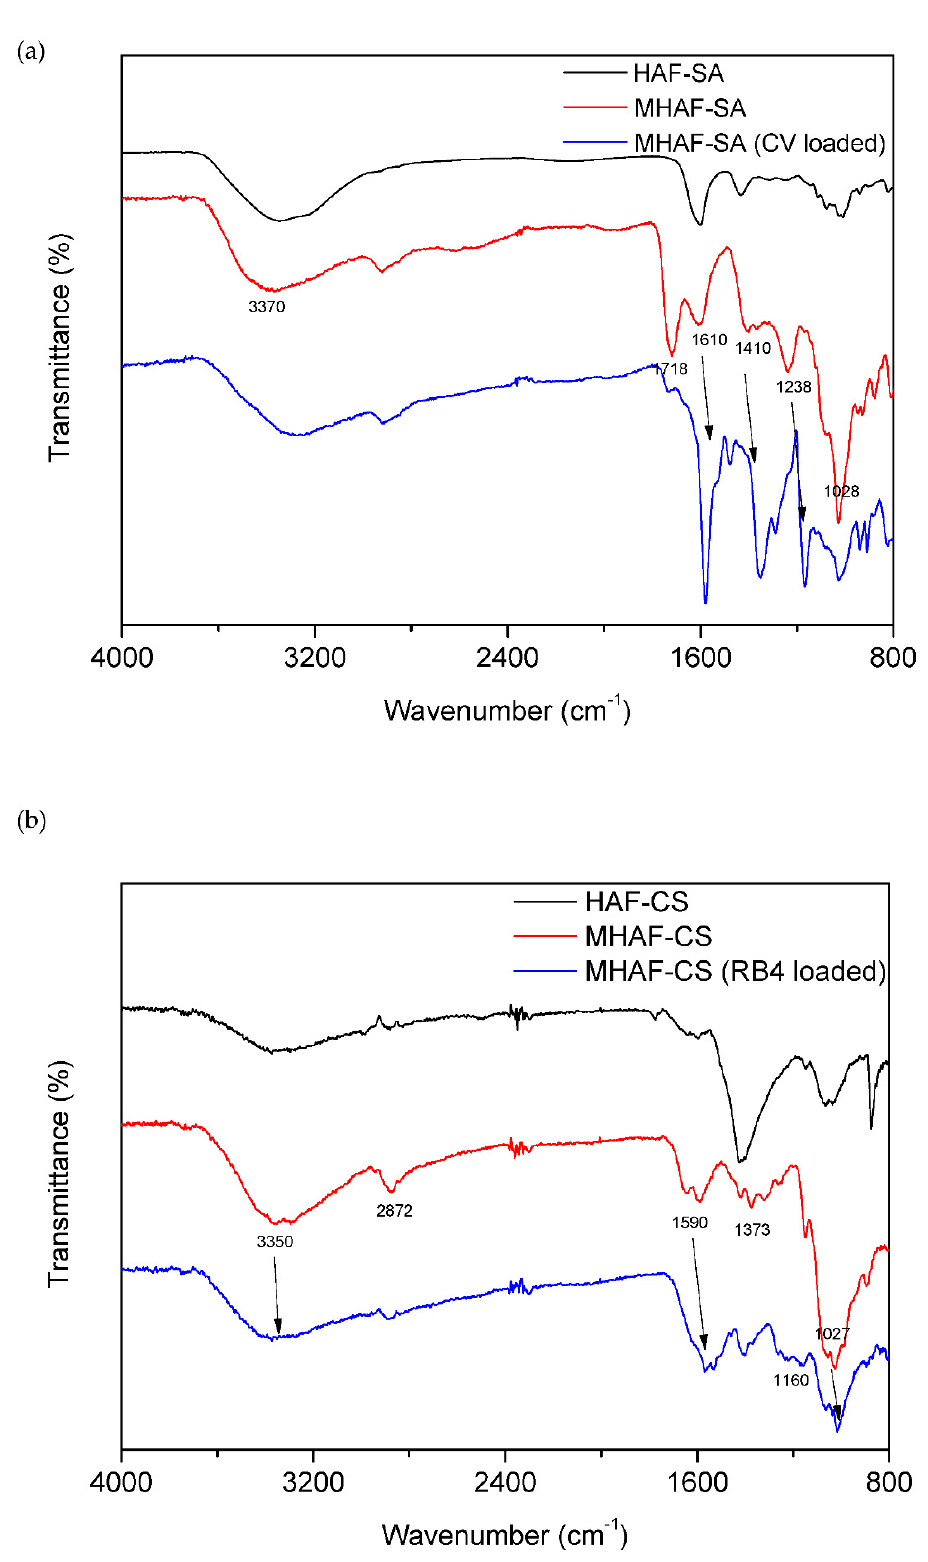
Figure 1. FTIR spectra of ( a ) MHAF-SA hydrogel beads and ( b ) MHAF-CS hydrogel beads.